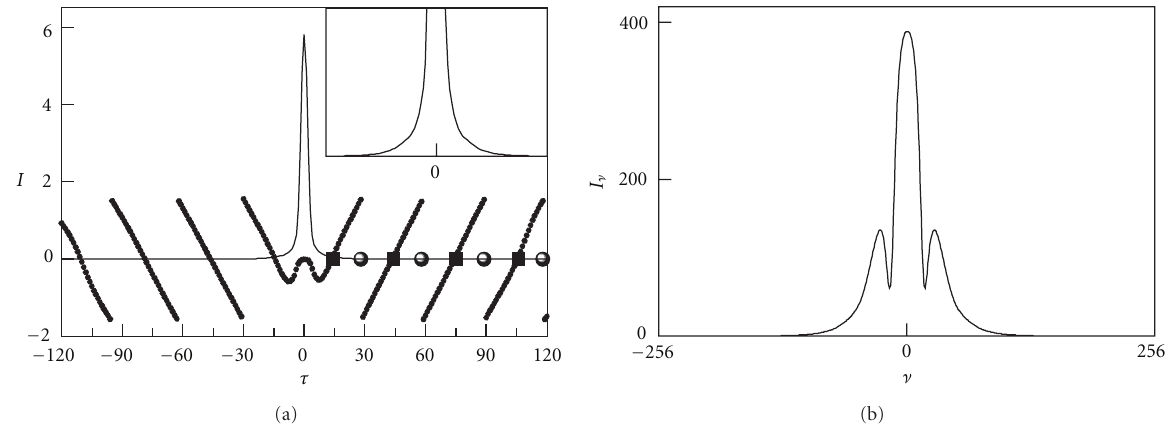
Figure 10: Temporal (a) and spectral (b) distributions of radiation for the single-soliton passive mode-locking. The upper right inset in (a) shows the multiplied soliton pedestal. The change of the phase along the pulse is presented in (a). All phase magnitudes are reduced to the interval ( − π ,+ π ). In the point of the pulse with a maximum amplitude, the phase is equal to zero. The black squares and circles correspond to the points of the pulse where its phase is equal to π and 0, correspondingly.